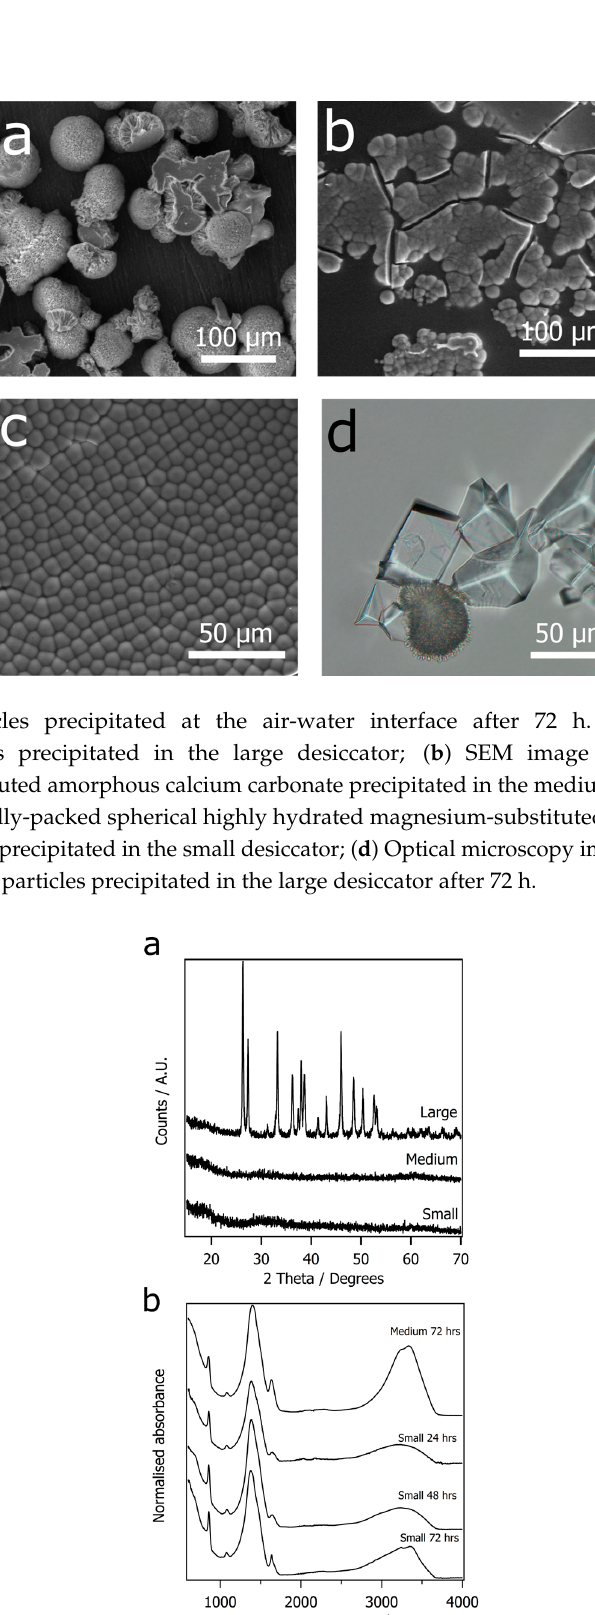
Figure 3. PXRD patterns and IR spectra of particles formed at air-water interface. ( a ) PXRD patterns of precipitates removed from the air-water interface after 72 h from reaction vessels in the small, medium, and large desiccators; ( b ) IR spectra of precipitates removed from the small and medium desiccator at varying time points.